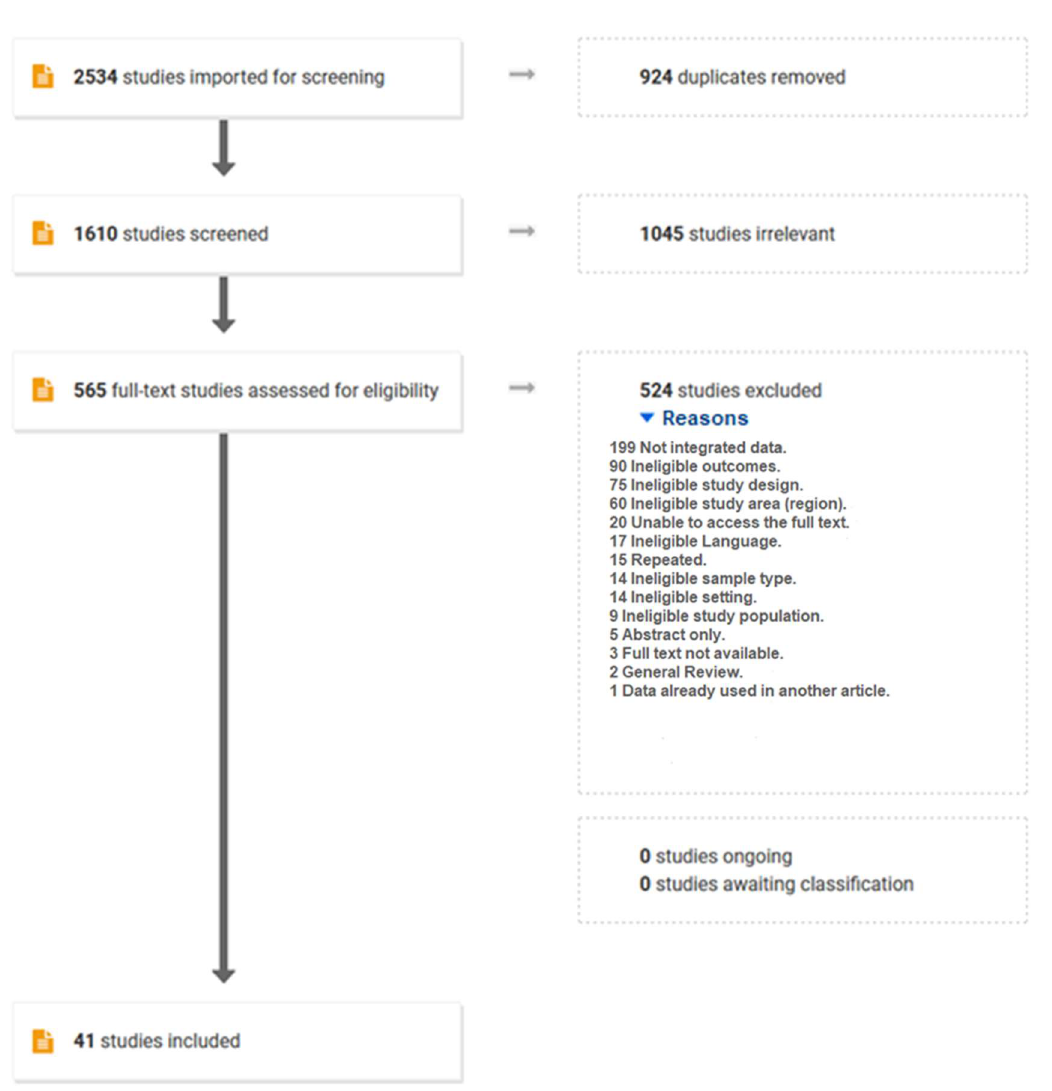
Figure 1. Search strategy and PRISMA flow